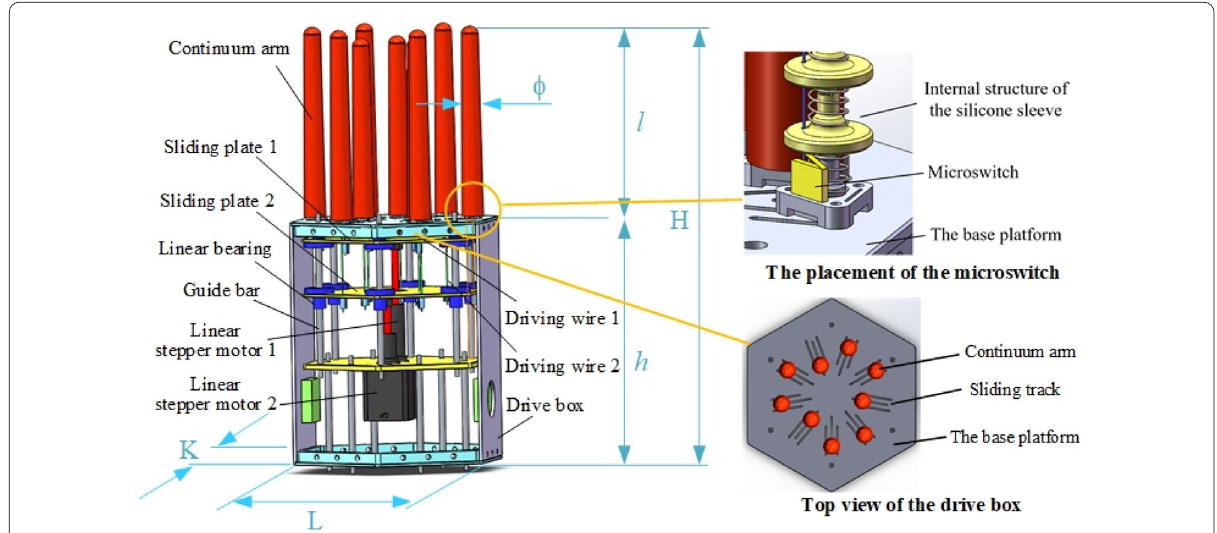
Figure 2 Design of the capture mechanism inspired by sea anemone